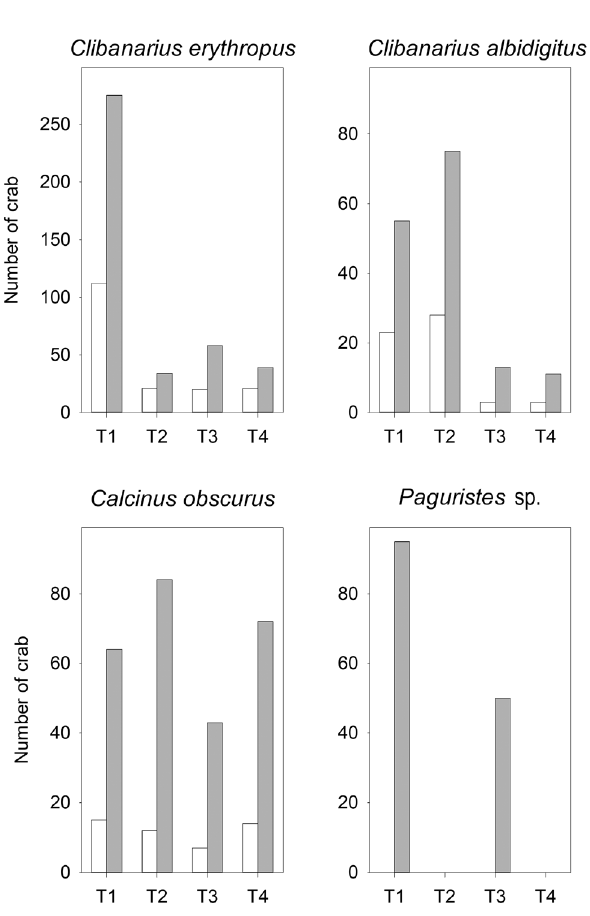
Figure 6. Number of non-ovigerous females (Fn), ovigerous females (Fo) and males (M) for each hermit crab species and shell type (Type 1 to Type 4), which were exhibiting air-exposure behavior on rocks (open bar) and those clustering under rocks (filled